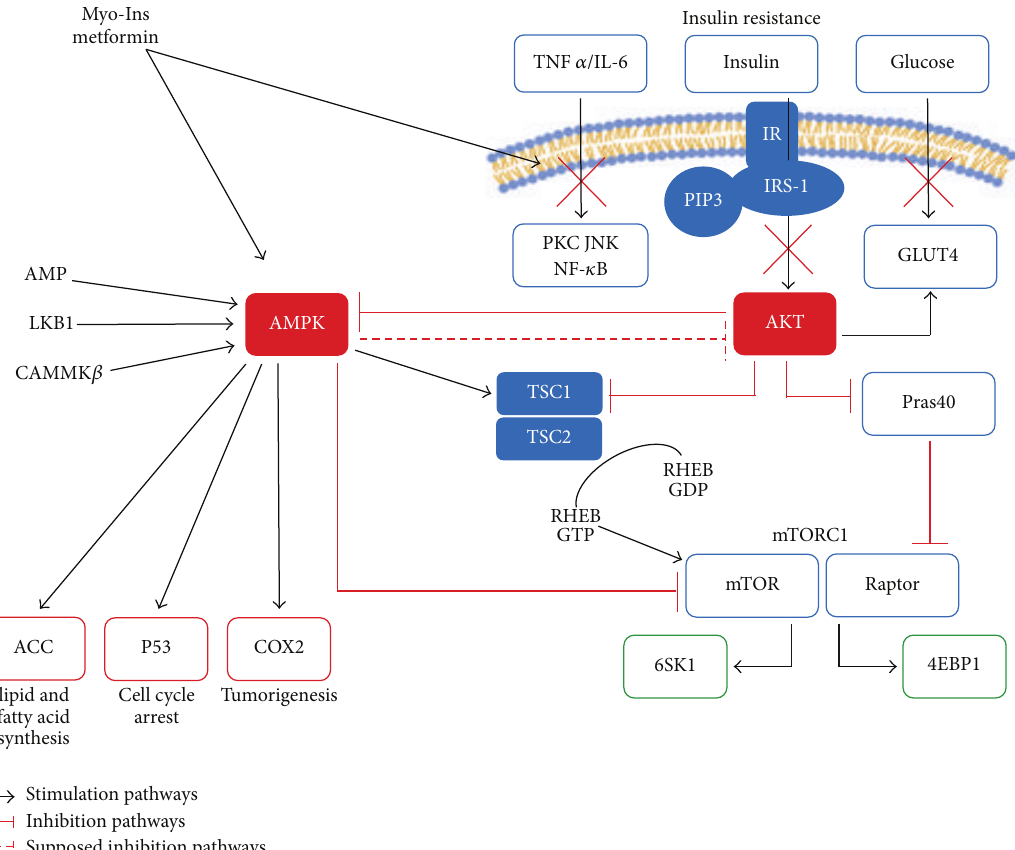
Figure 3: Negative regulation exerted by insulin-sensitizing on the molecular mechanism feeding insulin resistance. Role of AMPK as a metformin and myo-Ins molecular target. AMPK activation induces COX2 inhibition, p53 expression, and mTORC1 silencing through TSC2 and Raptor phosphorylation. The regulating activity of AMPK in processes of tumour induction and progression suggest that metformin may be proposed as an anticancer agent. TNF 𝛼 : Tumour Necrosis Factor 𝛼 ; IL-6: interleukin 6; IR: insulin receptor; PKC: protein kinase C; JNK: c-Jun N-terminal Kinase; NF 𝜅 B: nuclear factor 𝜅 B; IRS-1: insulin receptor substrate 1; PI(3,4,5)P3: phosphatidylinositol 3,4,5- trisphosphate; Akt: protein kinase B; GLUT4: glucose transporter type 4; TSC1: tuberous sclerosis 1; TSC2 tuberous sclerosis 2; AMPK 5 󸀠 : adenosinemonophosphate-activatedproteinkinase;AMP:adenosinemonophosphate;LKB1:liverkinaseB1;CaMKK 𝛽